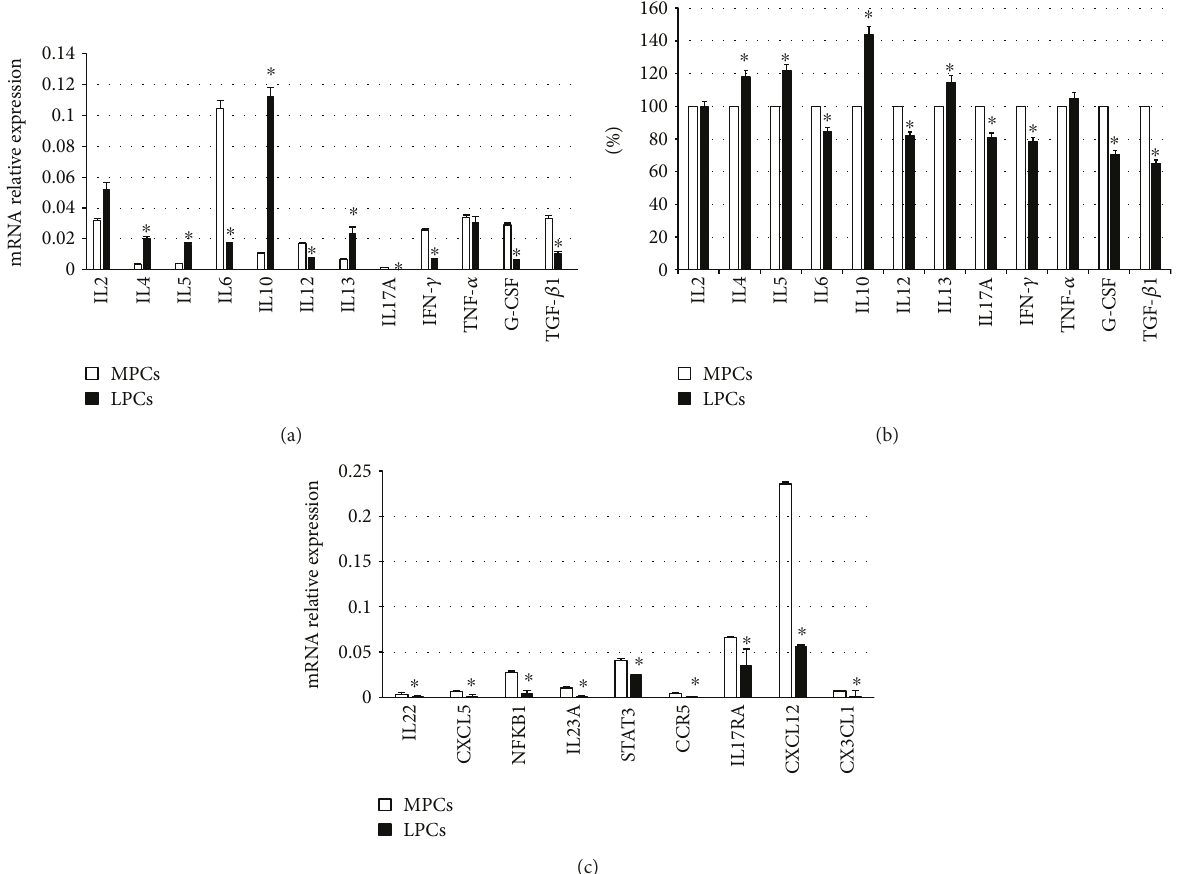
Figure 7: Expression of selected cytokines in myometrium progenitor cells (MPCs) and leiomyoma progenitor cells (LPCs). (a) Quanti fi cation of mRNA expression in MPCs and LPCs was calculated with the 2 − Δ Ct method, where Δ Ct =Ct (gene of interest) − Ct (housekeeping gene). Δ Ct was calculated for the selected genes on 12 di ff erent cultures. Subsequently, mean ± SD from three independent experiments in triplicates was calculated for LPCs and displayed. ∗ p < 0 05 LPCs versus MPCs. (b) ELISA test; the levels measured in MPCs were considered as 100% and those detected in LPCs accordingly calculated; ∗ p < 0 05 LPCs versus MPCs. (c) Selected Th1/Th17 pathway molecules evaluated by RT-PCR. Quanti fi cation of mRNA expression in MPCs and LPCs was calculated with the 2 − Δ Ct method, where Δ Ct=Ct (gene of interest) − Ct (housekeeping gene). Δ Ct was calculated for the selected genes on 12 di ff erent cultures. Subsequently, mean ± SD from three independent experiments in triplicates was calculated for LPCs and displayed. ∗ p < 0